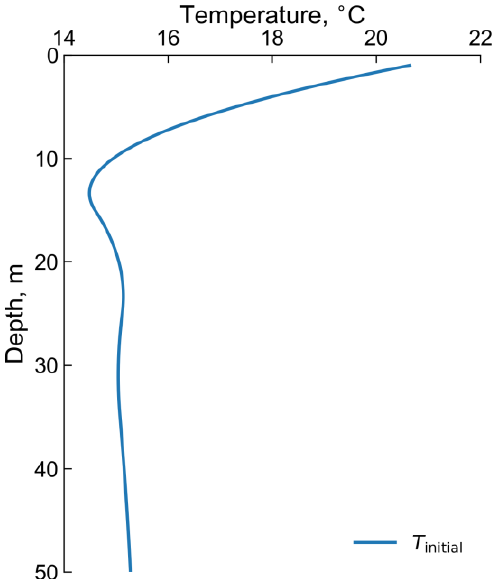
Figure 5. Undisturbed initial temperature of the ground with depth.